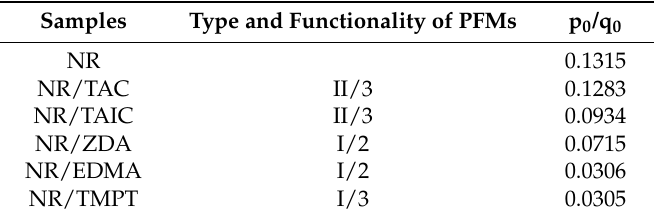
Table 3. Compositional characteristics, designation and p 0 /q 0 ratio for NR and NR/PFMs samples.